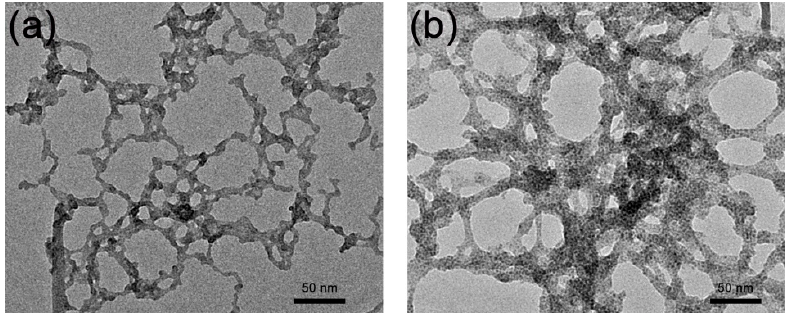
Figure 2. Transmission electron microscopy (TEM) images of ( a ) quantum dots (QDs) and ( b ) the NAC-QD complex.